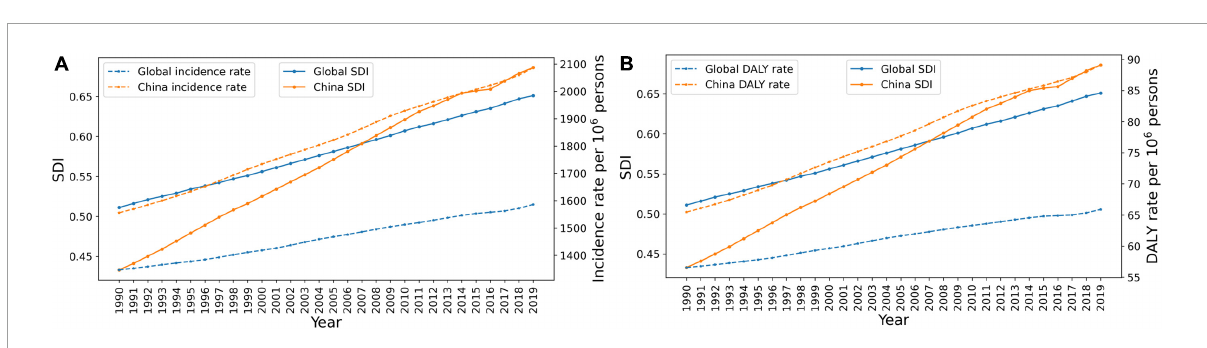
FIGURE4 The relationship between acne vulgaris and sociodemographic index (SDI) in China and around the world. (A) The relationship between age-standardized incidence rate of acne and SDI. (B) The correlation between acne disability-adjusted life year (DALY) rate and SDI.